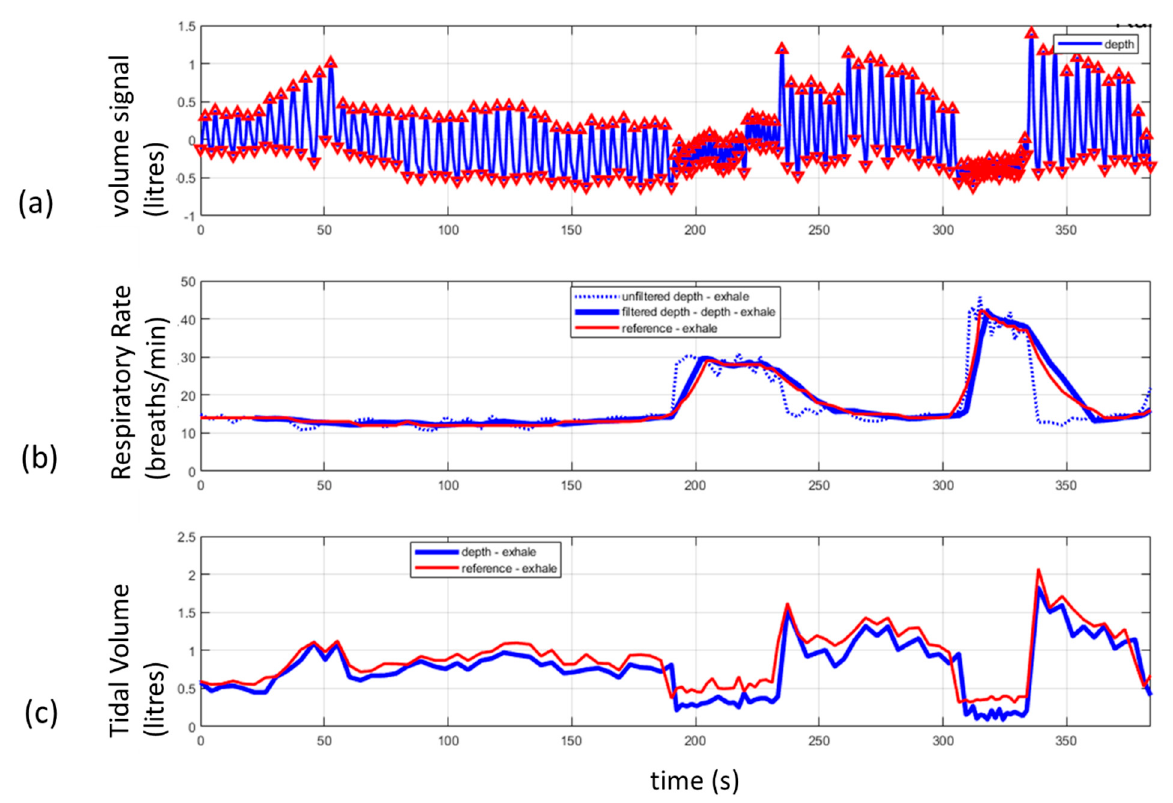
Figure 3. An example of respiratory rate and tidal volume derived from a depth sensing system. ( a ) The volume signal obtained from a depth sensing camera. The signal was generated by the subject varying his tidal volume over time. ( b ) The raw and filtered respiratory rate from a depth system compared to a ventilator reference. ( c ) The tidal volume computed from the respiratory volume signal (peak to trough in ( a )) compared to a ventilator reference.